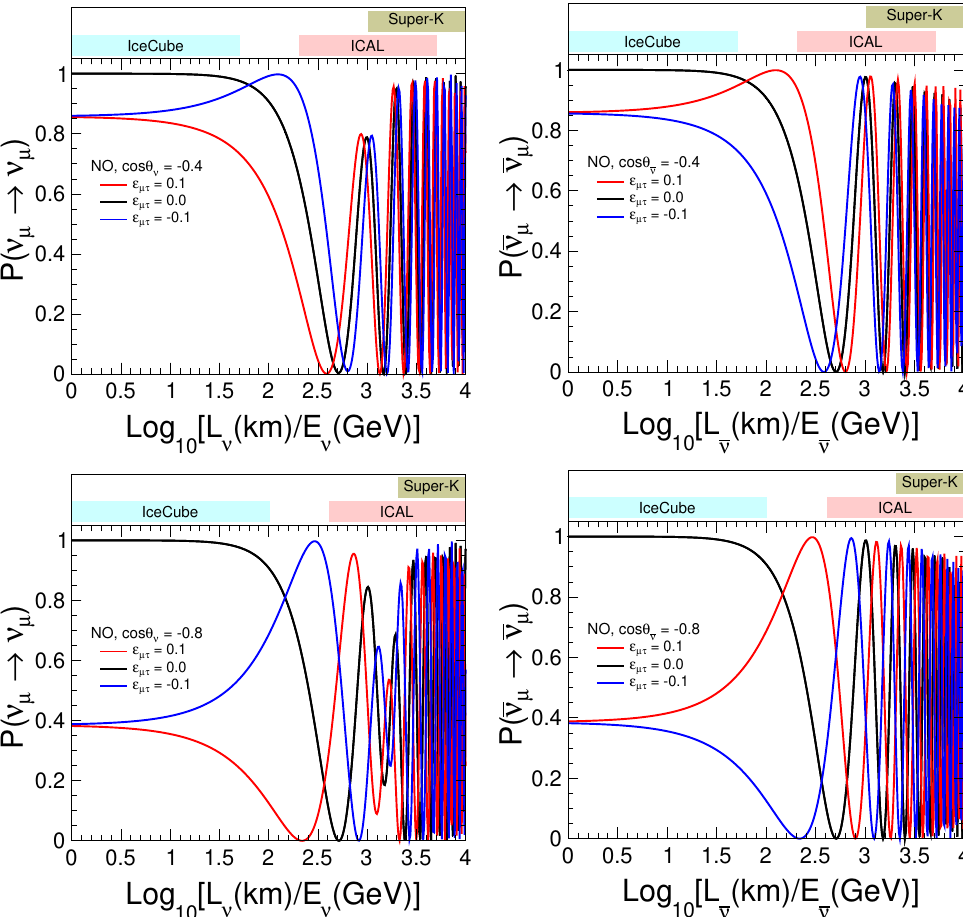
( L ) in left and right Figure 1 . The survival probabilities of ν µ and ¯ ν µ as functions of log ν /E ν 10 panels, respectively. The black lines correspond to ε = 0 (standard interactions: SI), whereas µτ red and blue lines are with ε = 0 . 1 , and − 0 . 1 , respectively. The neutrino direction taken in µτ upper (lower) panels is cos θ = − 0 . 4 ( − 0 . 8 ). The horizontal bands shown here are the indicative ν L ν /E ν ranges that these detectors are well-suited for. We consider normal mass ordering, and the benchmark oscillation parameters given in table